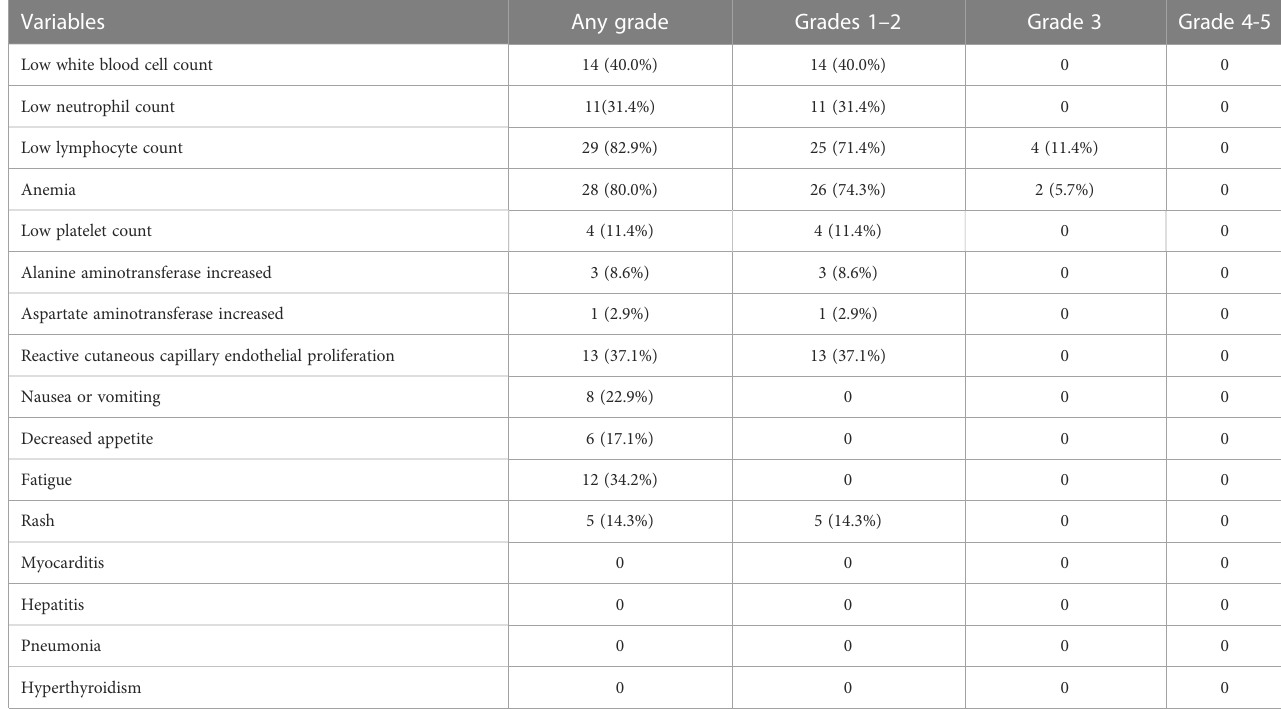
TABLE 2 Adverse events during neoadjuvant